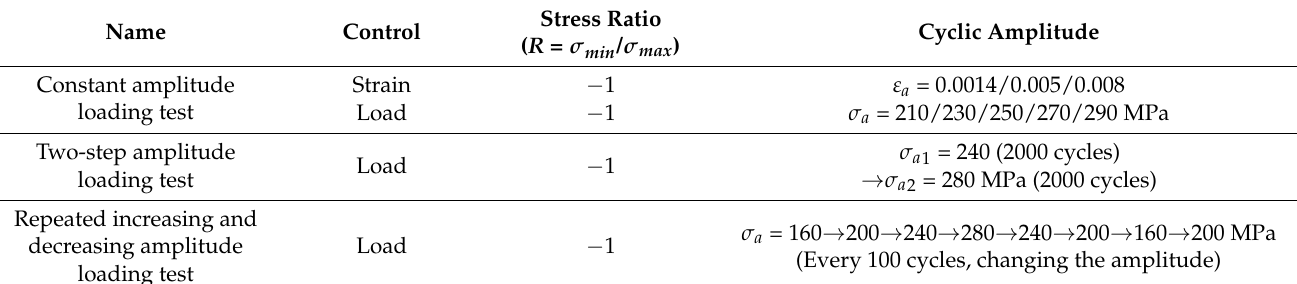
Table 3. Fatigue test conditions.